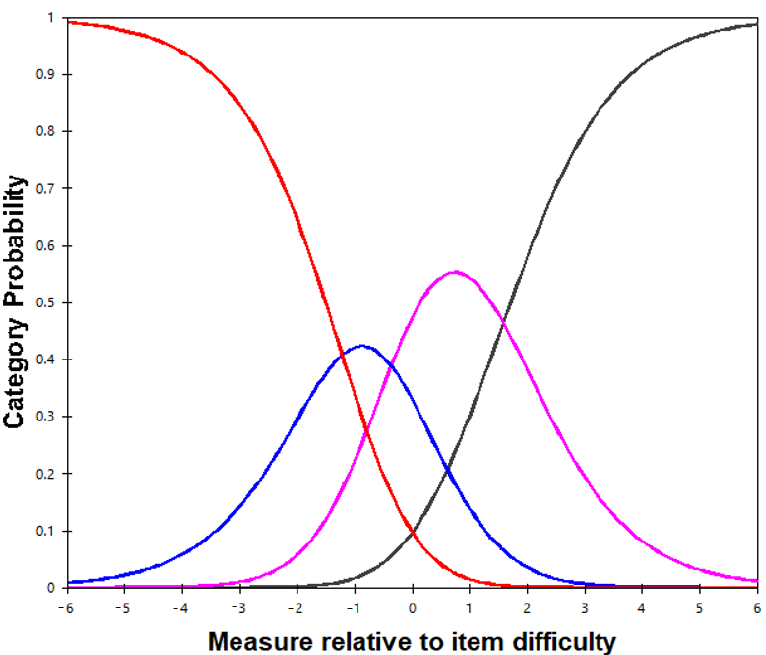
Figure 2. Category probability of the NPS. Notes: The curves for the NPS illustrate the range over which each of the four categories is most likely to be chosen. The red, blue, pink, and black curves on the graph represent the 4, 3, 2 and 1 NPS rating categories.